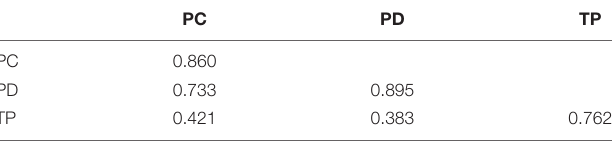
TABLE 4 | Discriminant validity (Fornell and Larcker criteria).